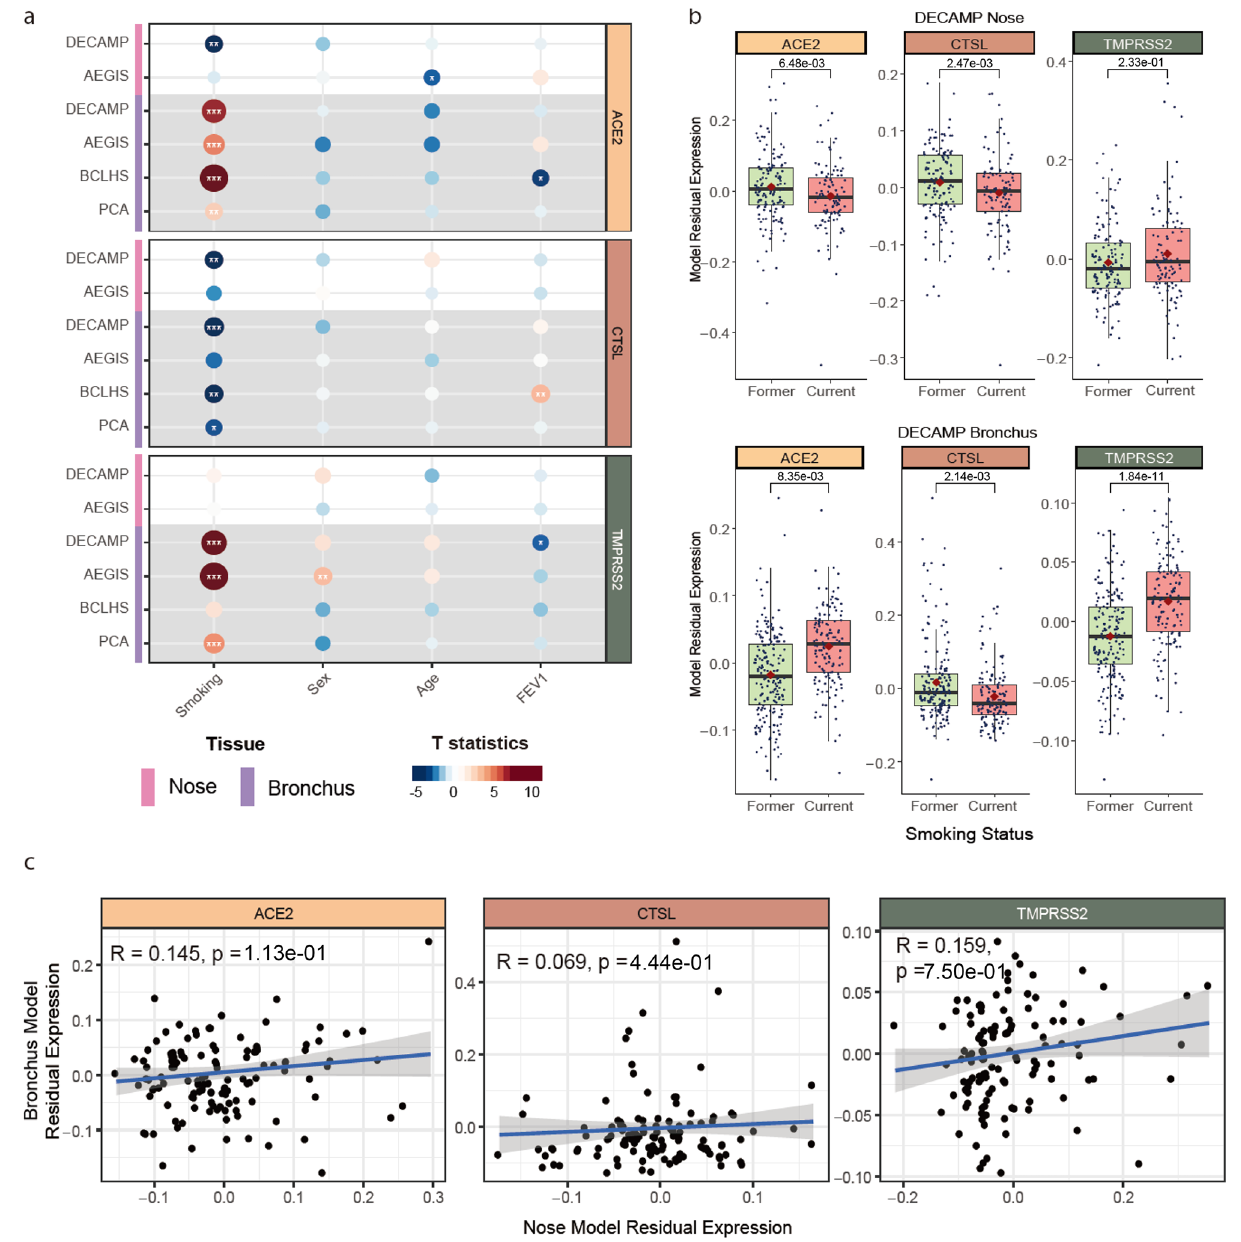
Figure 1. Differential association of VE gene expression between the nose and bronchus with respect to smoking. ( a ) Associations between the expression of ACE2 (tan), CTSL (brown), and TMPRSS2 (olive) and clinical covariates in the nasal and bronchial epithelium. Nasal (pink) and bronchial (purple) brushings were collected from subjects at high risk of developing lung cancer from four different studies (DECAMP bronchus: n = 341, AEGIS bronchus: n = 305, BCLHS bronchus: n = 238, PCA bronchus: n = 133, DECAMP nose: n = 253, AEGIS nose: n = 150). The size and color of the bubbles represent the significance and magnitude, respectively, of the t statistic calculated using linear modeling of VE gene expression as a function containing the four clinical variables, correcting for batch and mean Transcript Integrity Number (mTIN). Significance levels: * p < 0.05, ** p < 0.01, *** p < 0.001. ( b ) Boxplots showing the significance of associations between VE expression and smoking status in the DECAMP cohort, assessed by Student’s t test on residual counts after correction for sex, age, percentage of predicted FEV1, batch, and mTIN ( p < 0.05). ( c ) Expression of VE genes is not significantly correlated ( p > 0.05, Pearson correlation) between paired DECAMP nasal (x-axis) and bronchial (y-axis) epithelial samples (n = 123). Residual counts adjusted for sex, age, percentage of predicted FEV1, batch, and mTIN were used for the comparison. The blue line is the line of best fit and the gray shading represents the 95% confidence level interval for predictions from the linear